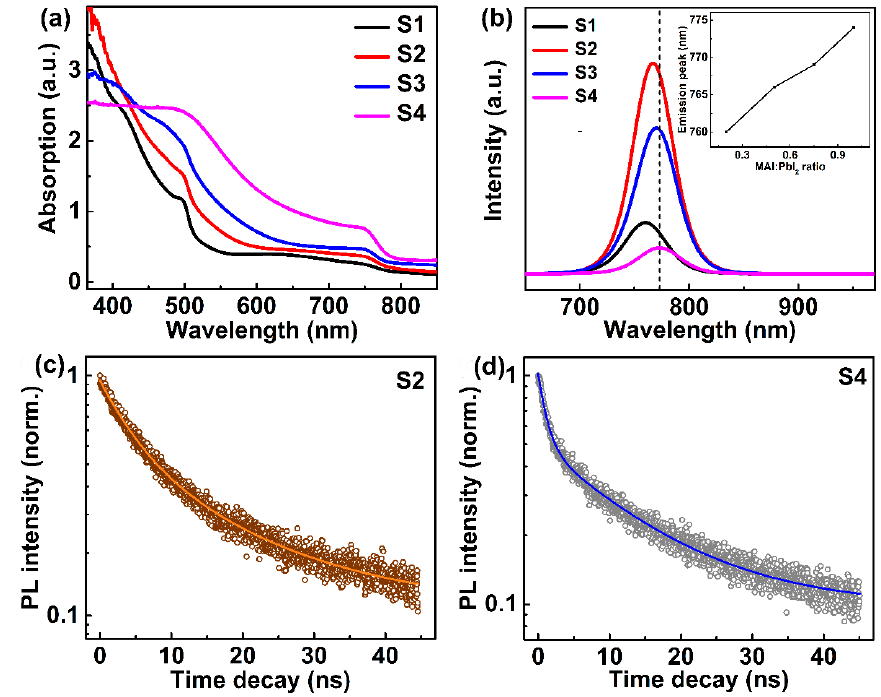
Figure 2. ( a ) Absorption spectra and ( b ) steady-state PL spectra of perovskite thin films with various MAI:PbI 2 ratio. ( c ) TRPL spectroscopy and corresponding curve fitting of S2 (MAI:PbI 2 ratio 0.5:1) and ( d ) S4 (MAI:PbI 2 ratio 1:1).